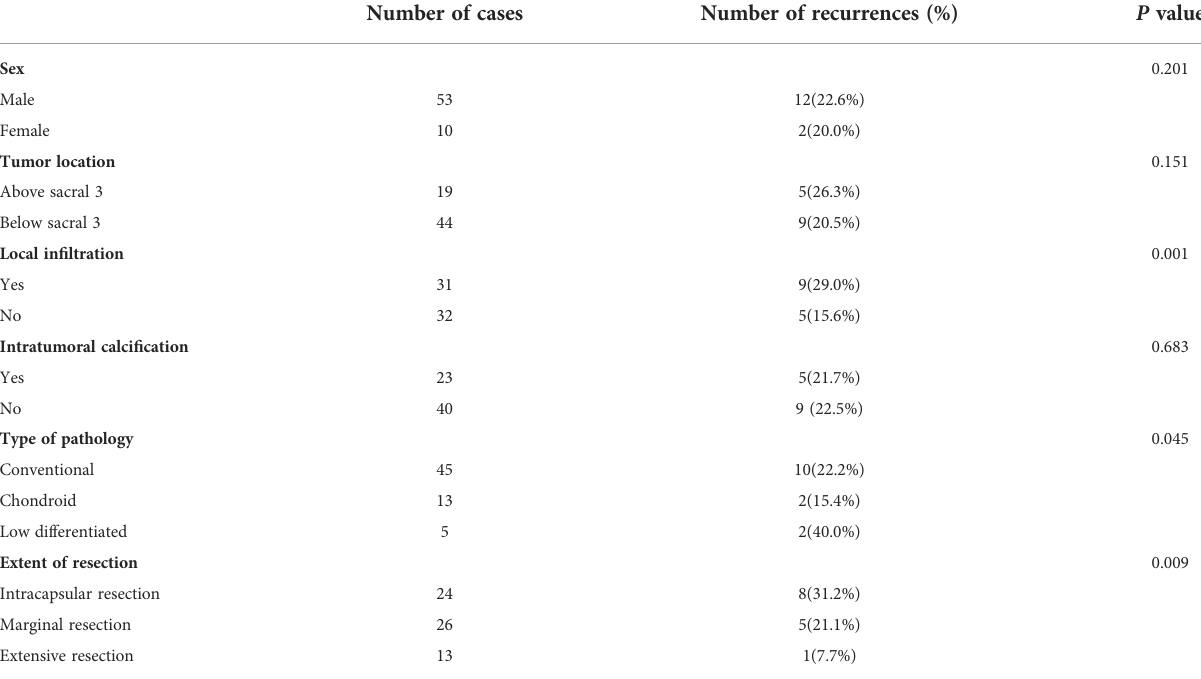
TABLE 1 Results of a univariate Kaplan-Meier survival analysis affecting postoperative recurrence of sacrococcygeal chordoma. Number of